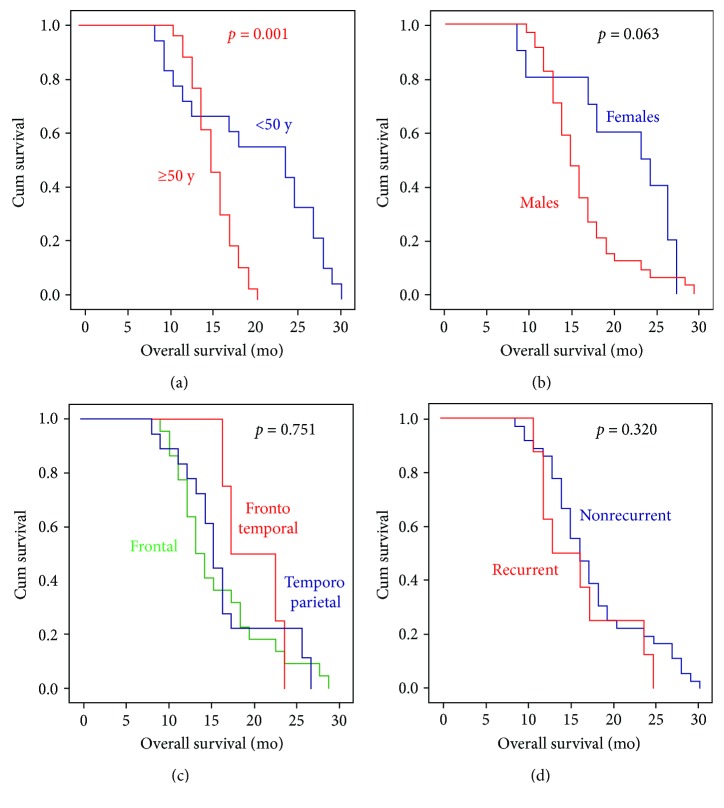
Kaplan–Meier survival curve in GBM patients. Log-rank (Mantel-Cox) test was used for comparison. Statistical significance at p < 0.05.